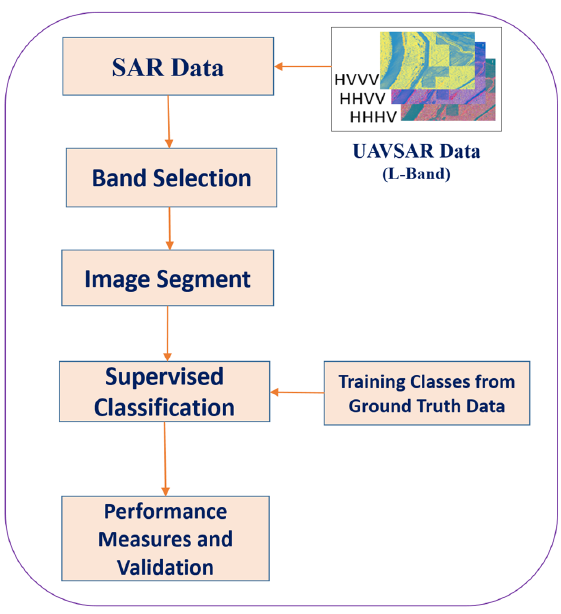
Figure 3. Supervised classification workflow for slide detection on levee.